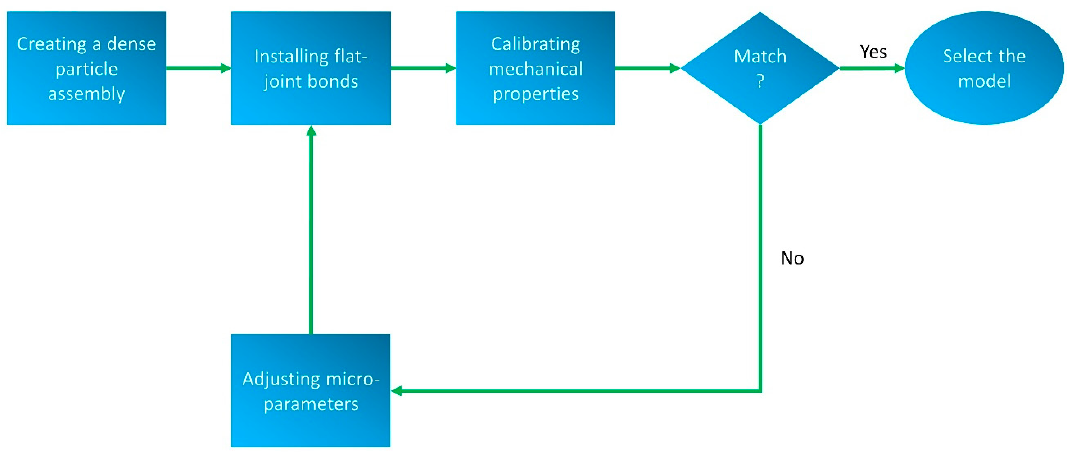
Figure 1. Flow chart of the specimen creation procedure.